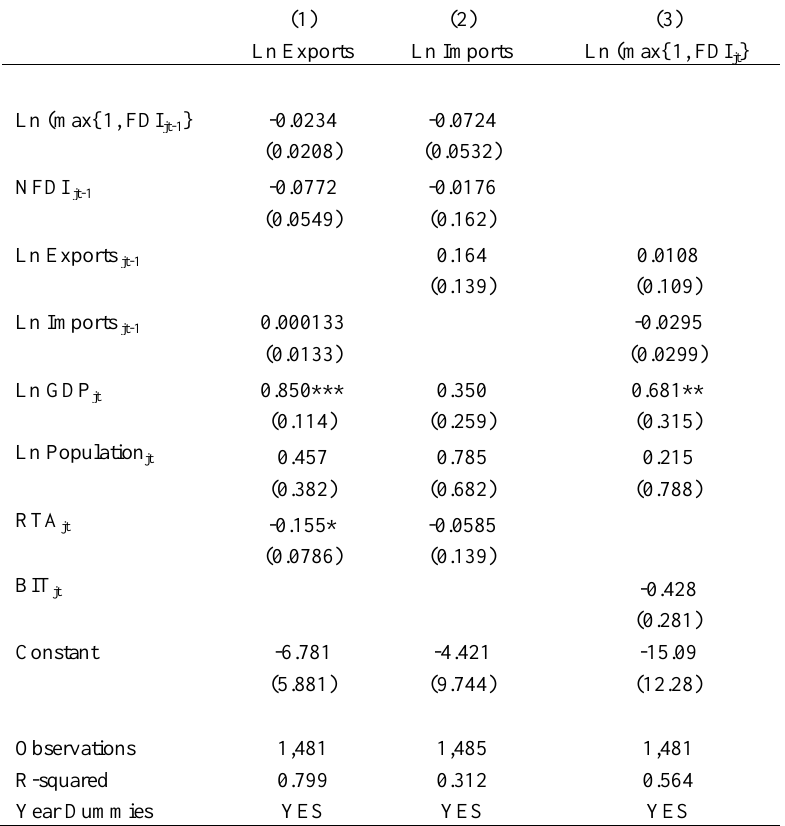
Table A2 . Results with Fixed Effects